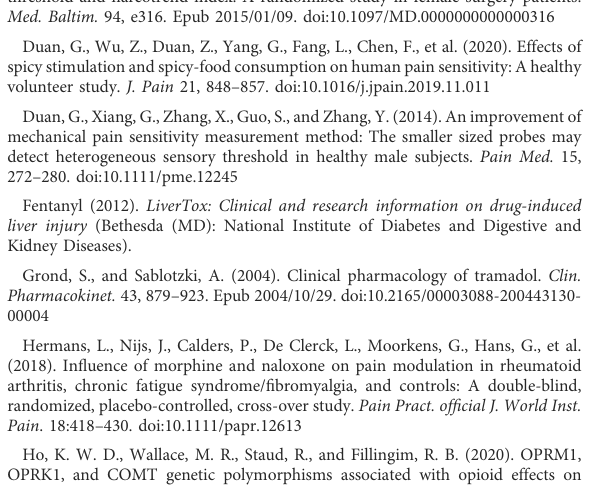
SUPPLEMENTARY FIGURE S1 Comparisons of the mean arterial pressure (1) and heart rate (2) during test procedure between the morning and afternoon groups for patients receiving sufentanil (A) , dezocine (B) and tramadol (C)